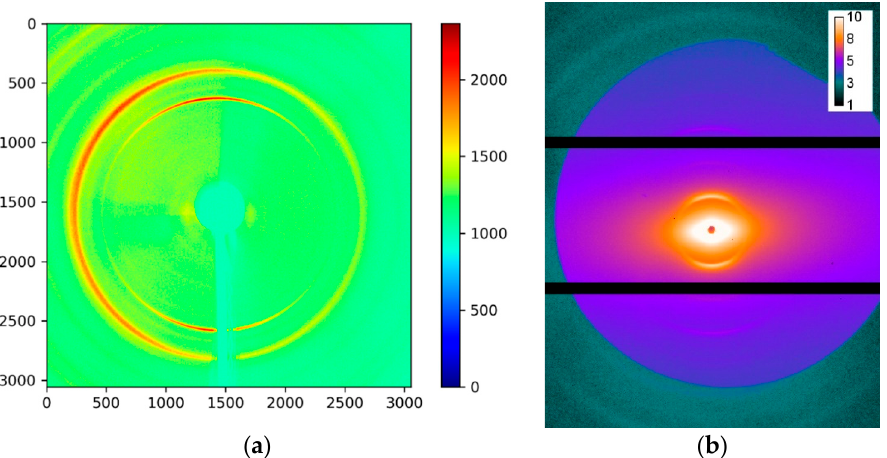
Figure 2. 2D ( a ) Wide-Angle X-Ray Scattering (WAXS) and ( b ) Small Angle X-Ray Scattering (SAXS) patterns, respectively. Colour bars show the intensity in arbitrary units (equivalent counts).